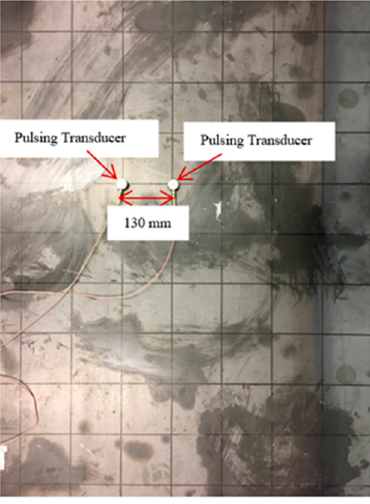
Figure 6. Rectangular pulsing pattern for exciting the source transducer.